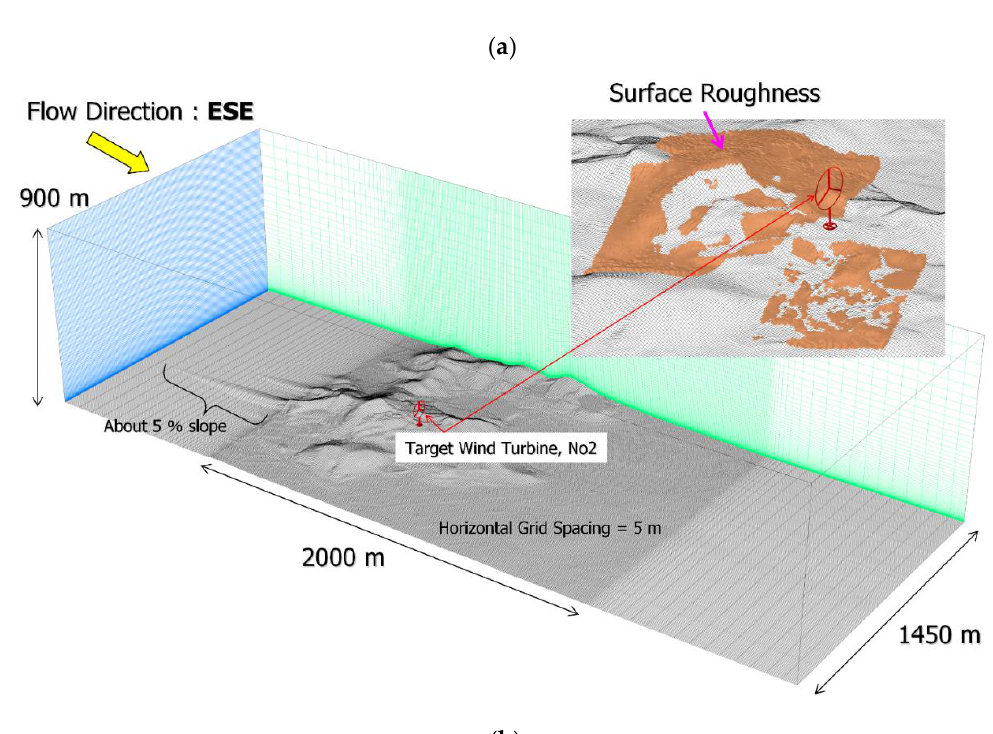
Figure 8. Computational grids for ( a ) Case1 and ( b ) Case2, Case3, and Case4.